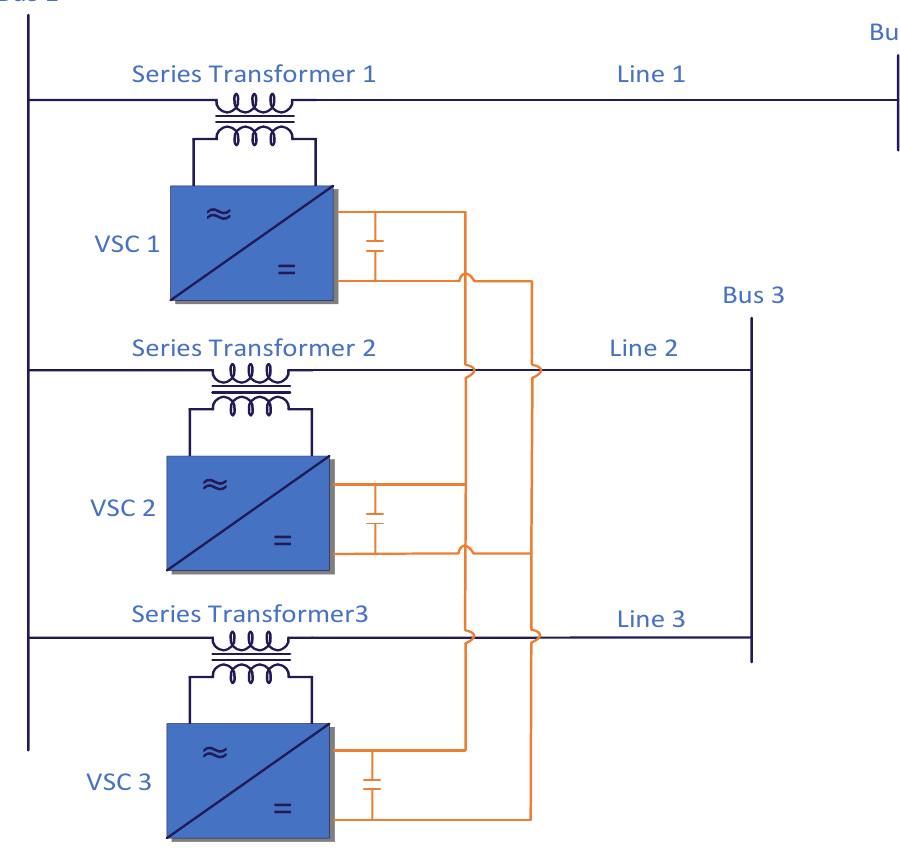
Figure 1. The structure of